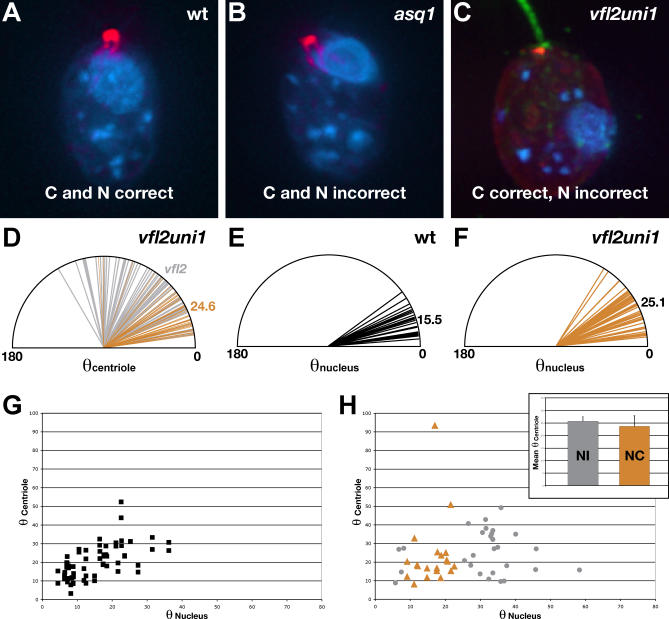
Centrioles Are Not Positioned by the Nucleus, but May Position the Nucleus(A) In wt cells, centrioles (red) are attached to the nucleus (blue) via centrin fibers (red). Both the centrioles (C) and nucleus (N) are properly localized near the apical part of the cell. Other plastid genomes are visible with DAPI staining (smaller blue dots).(B) asq1 cell showing centrioles (red) and nucleus (blue) mislocalize together.(C) When centrioles are uncoupled from the nucleus in vfl2uni1 cells, flagellated (green) mother centrioles (red) are properly localized to the apical side of the cell, whereas the nucleus (blue) can visit variable positions.(D) Mean θcentriole for mother centrioles in vfl2uni1 cells is 24.9 ± 14.7° (n =49, orange lines), which is significantly less than θcentriole for vfl2 cells (grey lines, one-tailed t-test p < 2.71 e−11), but not significantly different from wt.(E) wt cells have a mean θnucleus of 15.5 ± 8.1° (n = 58). θnucleus was determined by measuring the angle between the vector defining the long axis of the cell and a vector from the nuclear center of mass to the pyrenoid center of mass.(F) vfl2uni1 cells have a significantly higher (one-tailed t-test, p < 2.9 e−6) mean θnucleus of 25.0 ± 11.8° (n = 49) compared to wt.(G) θnucleus and θcentriole are correlated in wt cells, indicating that the position of the two organelles is coupled.(H) When the nucleus is detached from the centrioles in vfl2uni1 cells, the nuclear position no longer correlates to centriolar position. Scatter plot visually shows loss of correlation between θcentriole and θnucleus. Points are color coded into two groups of cells, those with a nucleus whose position is within the correct wt range (defined as θnucleus less than one standard deviation from wt mean, and plotted in orange) and those with a nucleus whose position is incorrect (defined as θnucleus more than one standard deviation from wt mean, and plotted in gray). The two groups of points classified in this manner span the same range of values for θcentriole, further supporting a lack of correlation between nuclear and centriolar position when the nucleus is detached from the centriole. Inset: the mean θcentriole (mean θcentriole = 25.7 ± 11.3°, gray bar, n = 29) of cells with an improperly positioned nucleus (NI) is indistinguishable from the mean θcentriole (mean θcentriole = 23.7 ± 18.8°, orange bar, n = 20) of cells with a correctly positioned nucleus (NC). This shows that the mother centrioles can still attain the correct localization regardless of nuclear position.